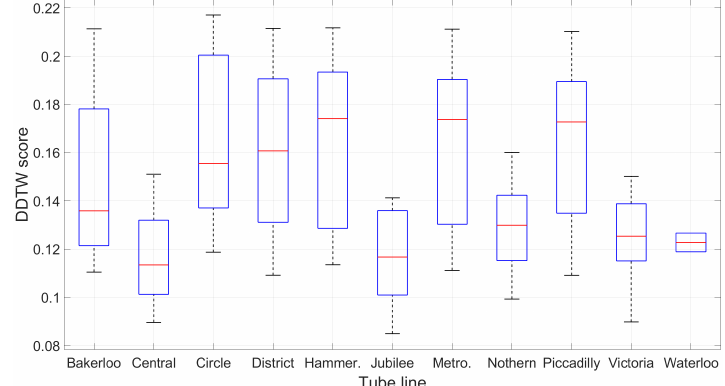
Figure 14. The distribution of the DDTW score for every possible 1-stop co-located trip on each line between the training database and each of the 4 test